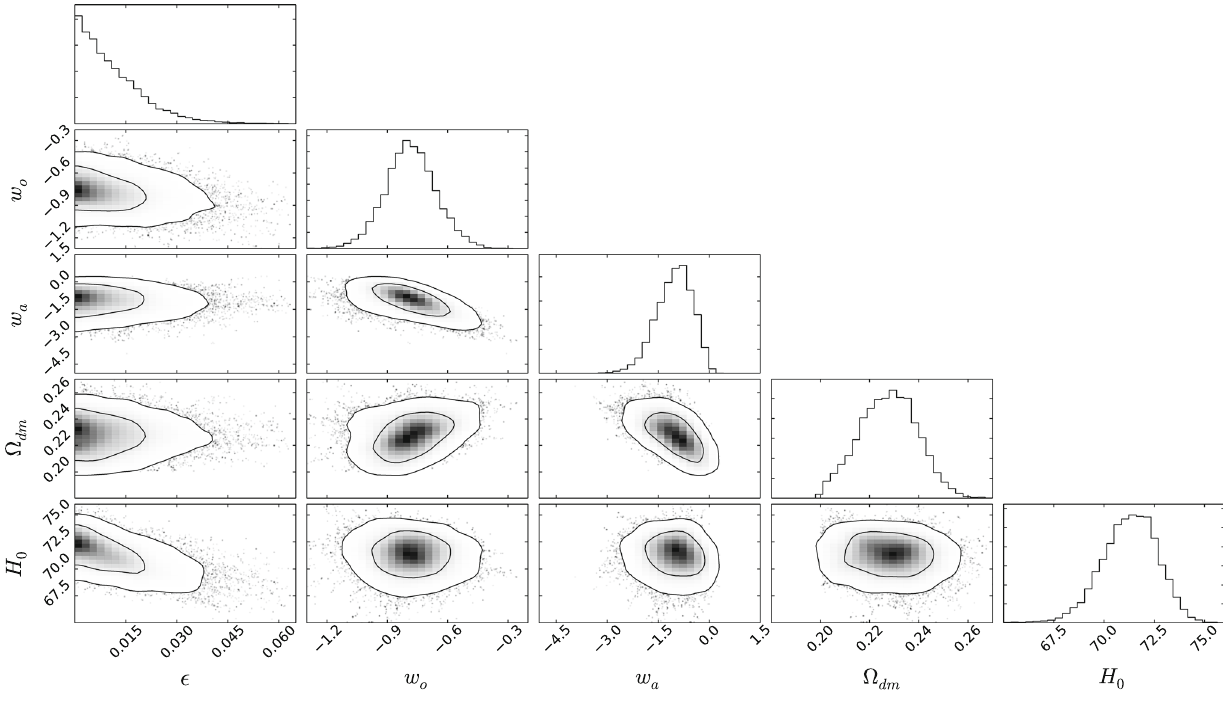
Fig. 2 The same as in Fig. 1 for P2 [49] as a Gaussian prior and flat priors for the other parame- ters. In particular, taking into account the constraint imposed on the (cid:7) parameter by [39], only positive epsilon values are